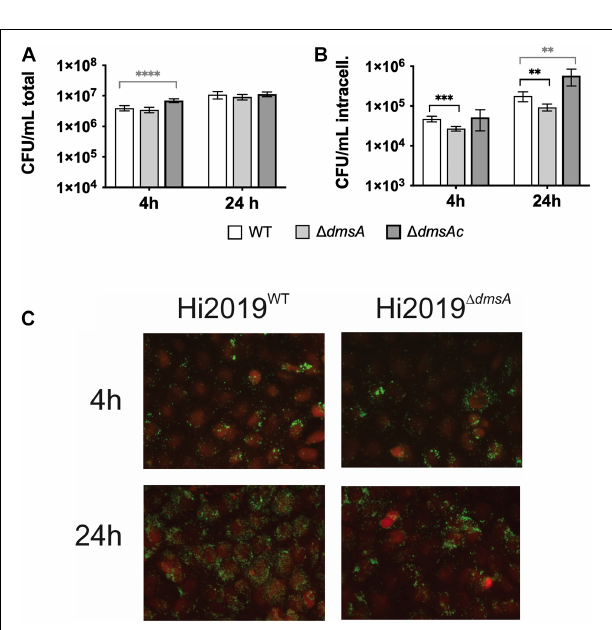
FIGURE 5 | Interaction of H. influenzae strains with 16HBE14 human bronchial epithelial cells. (A) Numbers of total tissue cell adherent bacterial colony-forming units (CFU) 4 or 24 h post-infection with Hi2019 WT Hi2019 (cid:49) dmsA or Hi2019 (cid:49) dmsAc . (B) Bacterial intracellular CFU at 4 and 24 h post-infection. (C) Fluorescence microscopy of 16HBE14 tissue cells infected with Hi2019 WT or Hi2019 (cid:49) dmsA . 16HE14 cells are stained with CellTracker orange; Hi2019 appears in green following antibody-mediated detection. While at 4 h post-infection both strains show similar colonization patterns, after 24 h growth of Hi2019 (cid:49) dmsA shows a different pattern with less even colonization of the tissue cells. Images are representative of three independent experiments. Statistical testing (A,B) used unpaired, two-tailed t -tests, ∗∗ p < 0.01, ∗∗∗ p < 0.001, ∗∗∗∗ p <